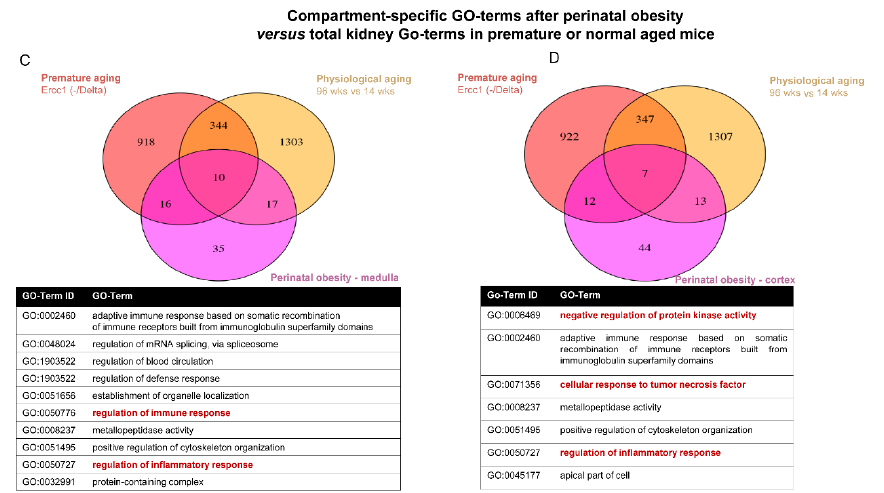
Figure 4. ( A , B ): Venn diagrams of significant ( p < 0.05) GO-terms show overlaps of naturally aged total kidneys and kidney medulla ( A ) or cortex ( B ) after perinatal obesity. ( C , D ): Venn diagrams of significant ( p < 0.05) GO-terms show overlaps in the three conditions: prematurely aged (total kidney), naturally aged (total kidney) and perinatal obesity (medulla, ( C ); cortex, ( D )). Tables show the terms shared among all two ( A , B ) or three ( C , D )